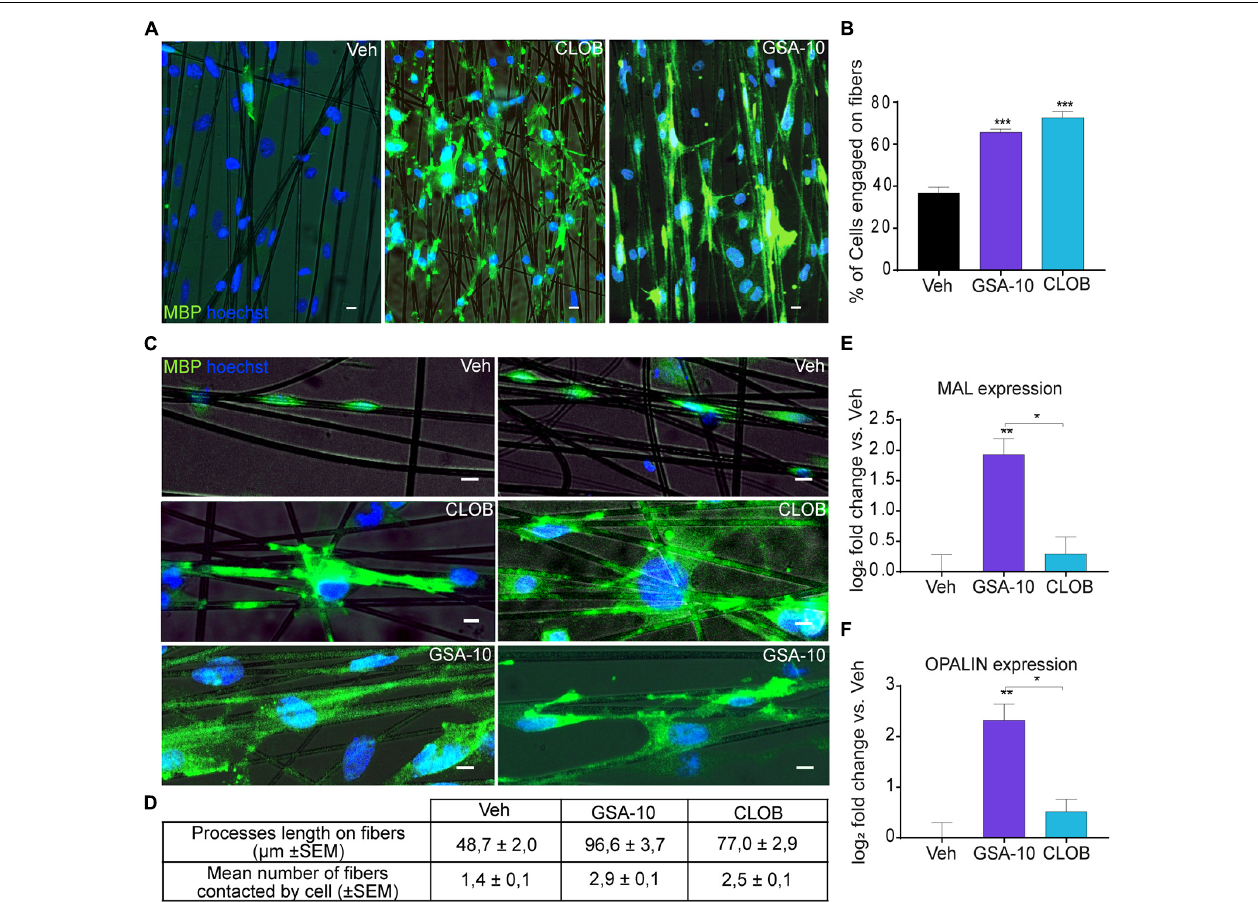
FIGURE 1 | GSA-10 promotes Oli-neuM differentiation until axon engagement and compact myelin marker expression. Oli-neuM was treated with 10 µ M GSA-10, 10 µ M Clobetasol, or vehicle for 72 h before analysis. (A) Representative epifluorescence microscopy images of Oli-neuM cells, treated as indicated, in chambers containing artificial axons (aligned microfibers). Cells were stained with anti-MBP primary and Alexa 488 secondary antibodies (FITC). Hoechst (blue) = nuclei. Scale bar = 10 µ m. (B) Quantification of fiber engagement was performed by analyzing 75 images per sample for each treatment ( n = 3). Specifically, the percentage of engaged cells (mean ± standard error of the mean, SEM) was estimated by counting nuclei located in fibers or within a range of 86 µ m from the fiber. (C) Enlargement of engaged cell morphology under the indicated treatments. Scale bar = 10 µ m. (D) Quantification of membrane lengthening and number of fiber contacts by engaged cells under the indicated treatments. 100 engaged cells randomly selected per treatment were analyzed. (E,F) Quantitative RT-PCR analysis of MAL and OPALIN expression. Data were plotted as log2 fold change versus vehicle (which was set as 0) ± SEM ( n ≥ 3). Two-tailed paired Student’s t test was performed for statistical significance versus vehicle, one-way analysis of variance (ANOVA) with Tukey’s multiple comparison test was performed to analyze statistical significance among different treatments. * p < 0.05, ** p < 0.01, and *** p <